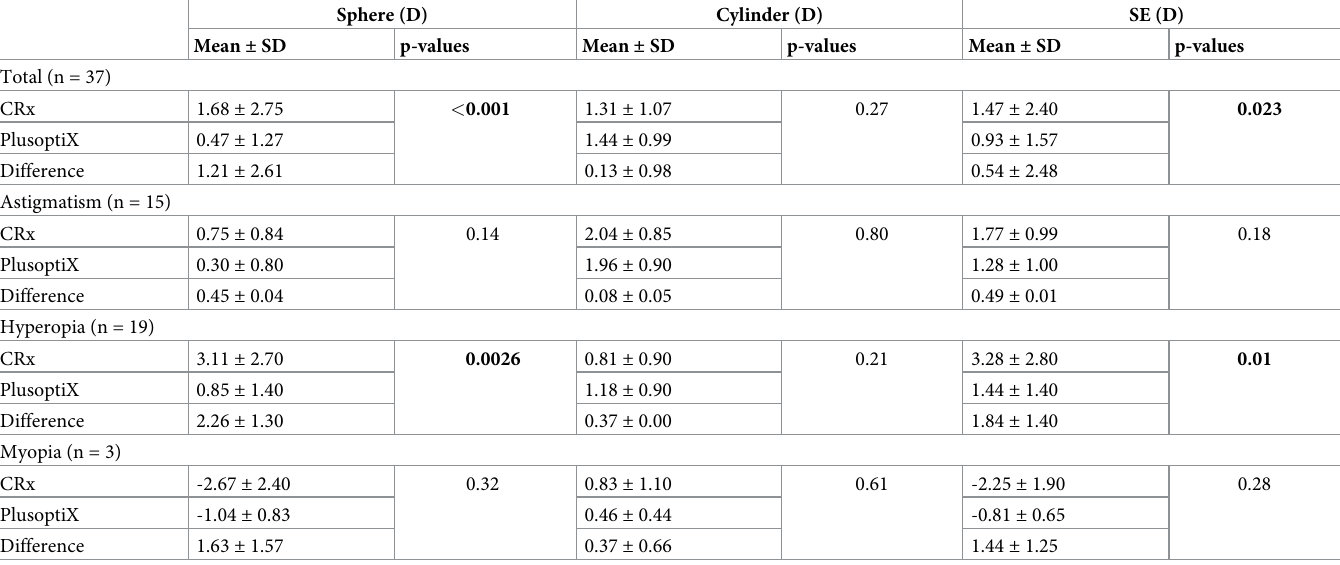
Table 3. Comparison between the plusoptiX and cycloplegic retinoscopy of the examined